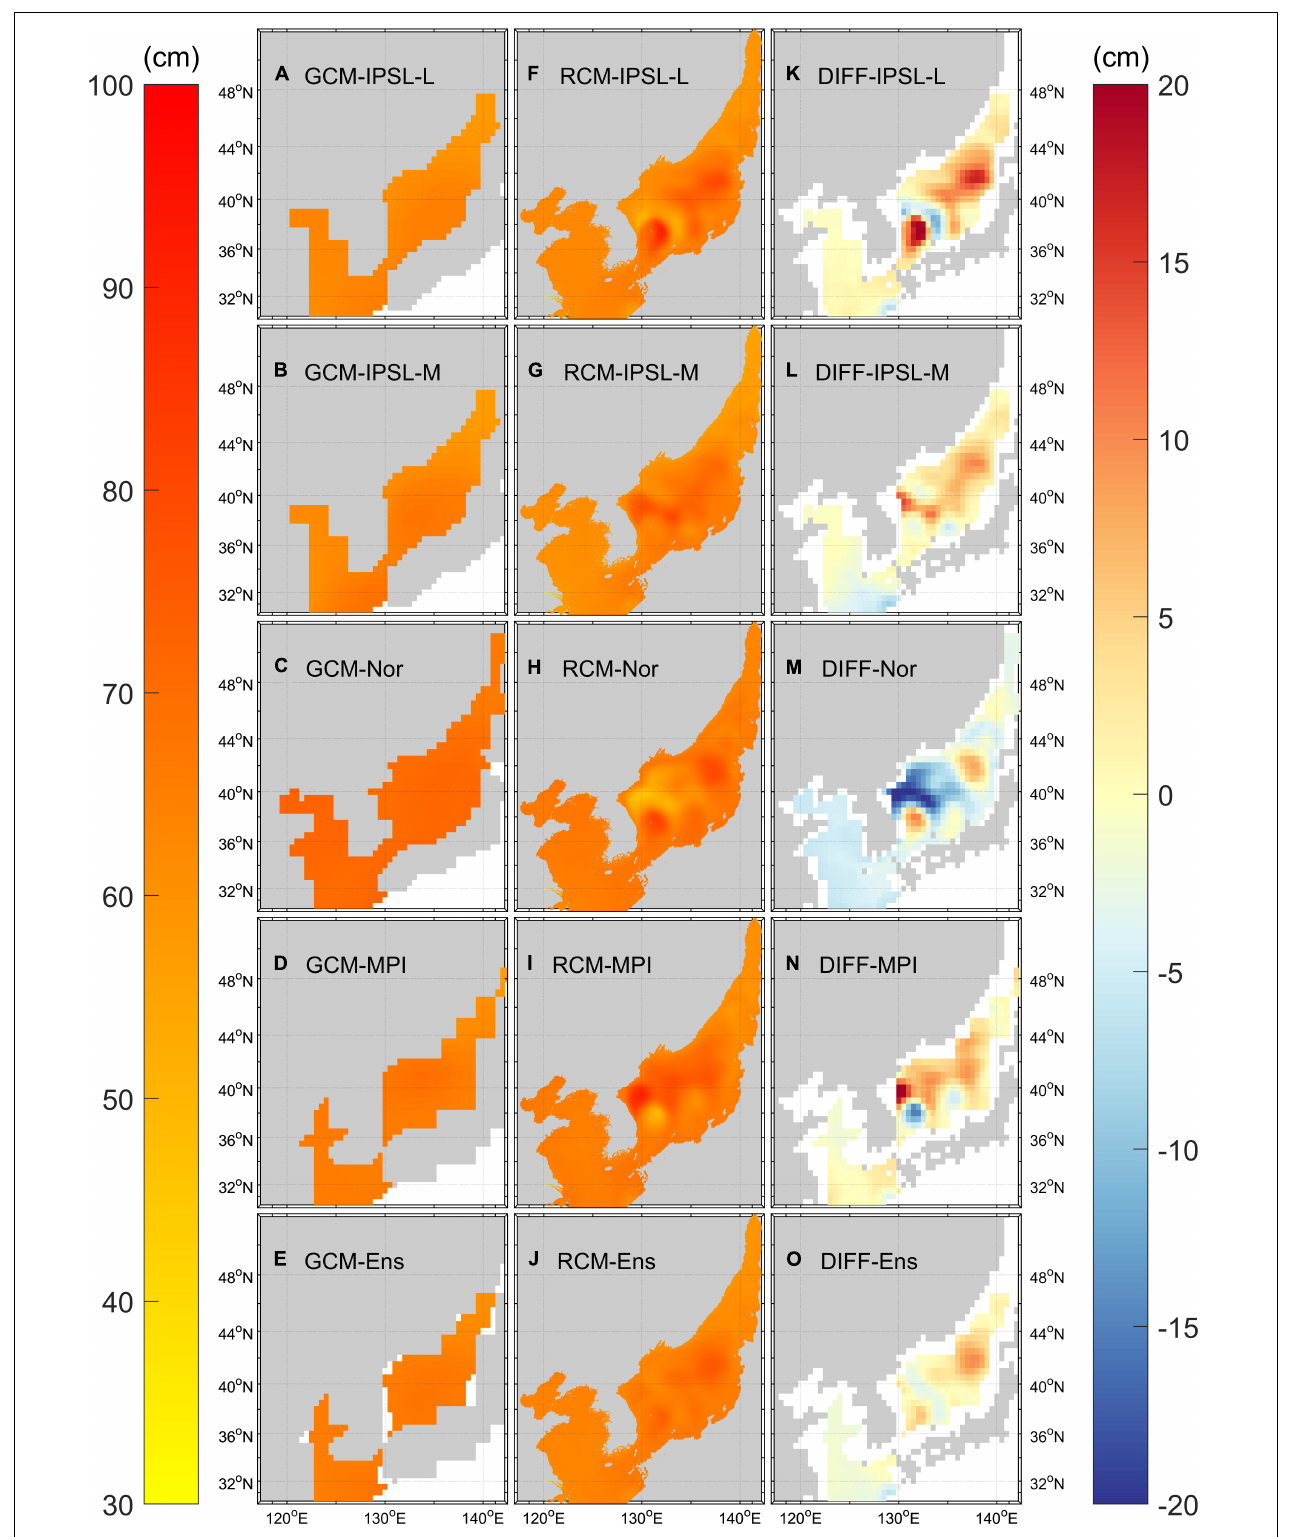
FIGURE 10 | Sea-level rise (unit: cm) between 1986–2005 and 2081–2100 in the NWP marginal seas under RCP 8.5 scenario according to panels (A–D) GCMs, and (F–I) RCMs. (E) and (J) represent the ensemble means of the GCMs and RCMs, respectively. Differences between the two modeling methods (RCM-GCM) are shown in panels (K–O)